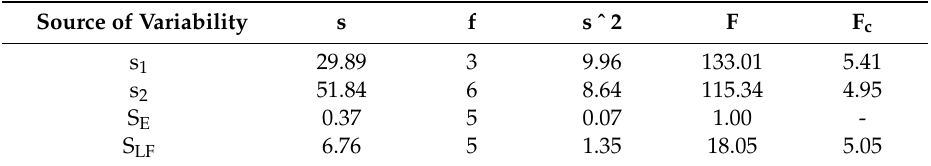
Table 3. Analysis of variance for yield of extractives.